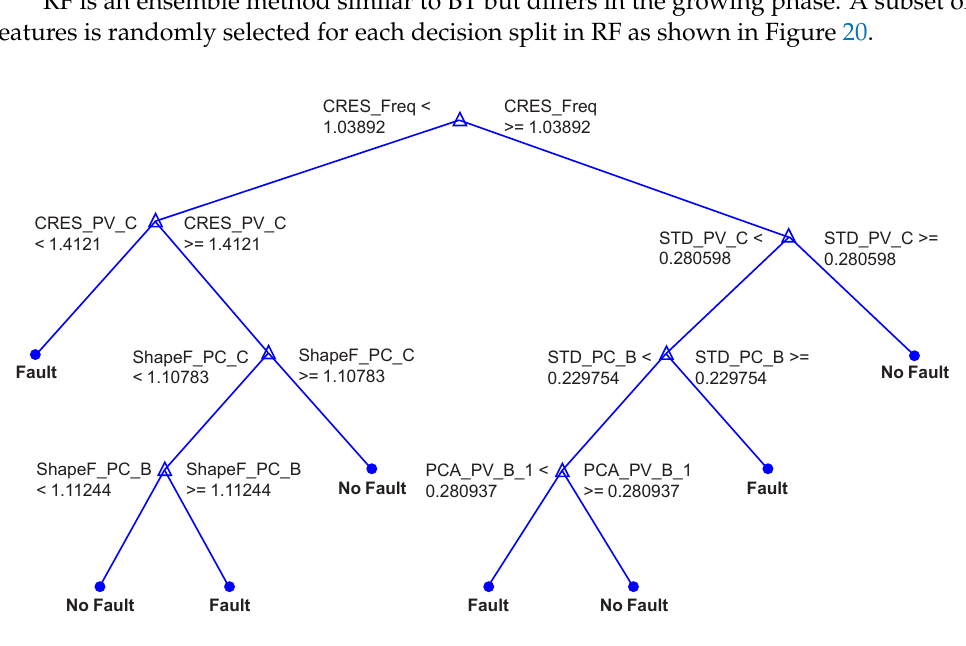
Figure 20. View of 4th Tree with 7 branches and 15 nodes.